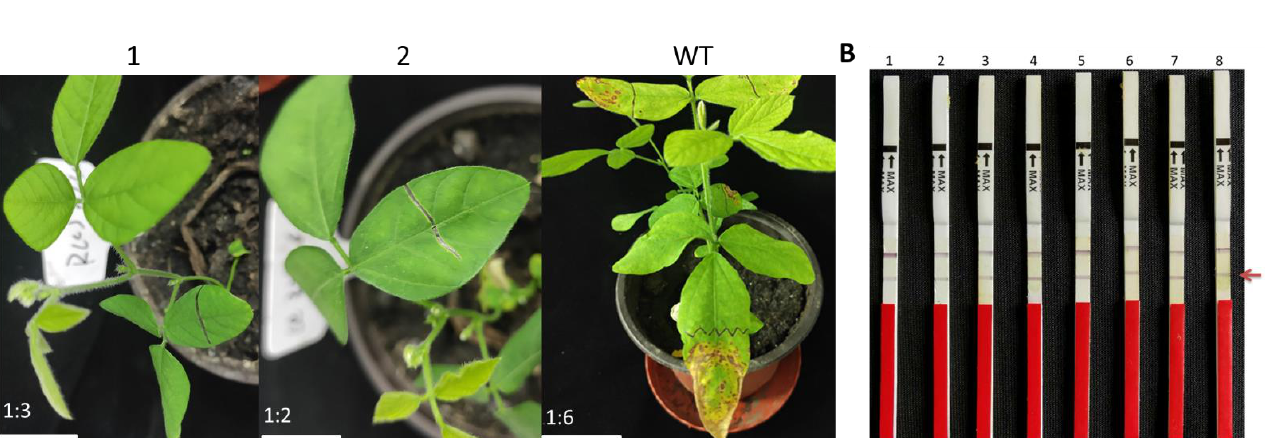
Figure A2. Sequencing results of PCR amplification product of bar and flanking region from genome DNA of 3-1 ( A ) and 31-1 ( B ) soybean. Bar gene’s sequences are in gray, genome DNA sequences are underlined, primers are highlighted in yellow. Appendix B Table A1. Primer pairs used in the study. GmWRI1a-P1